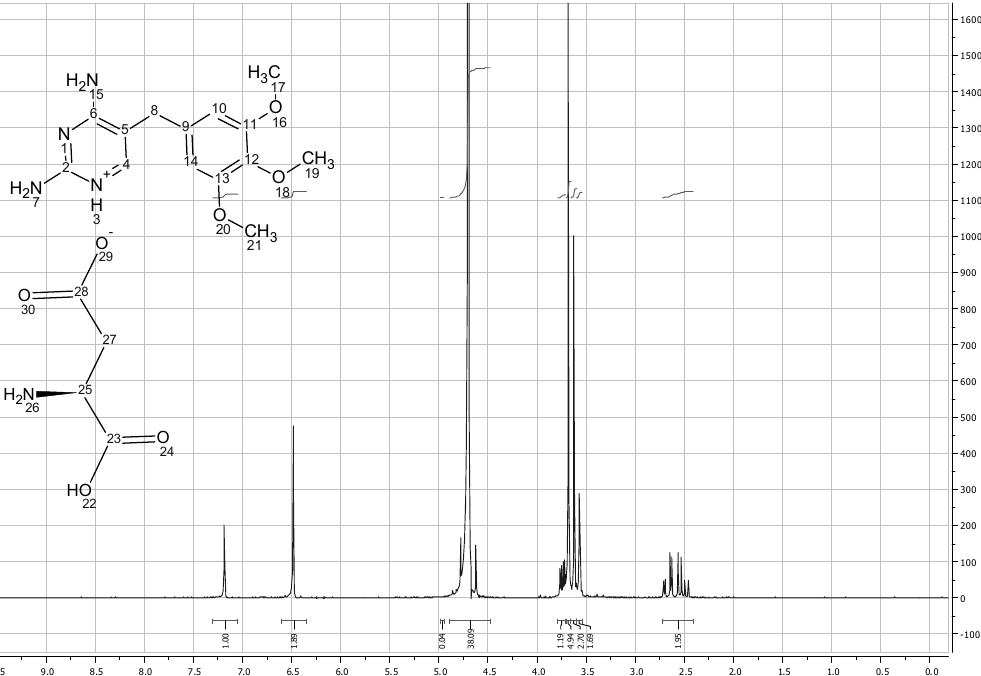
Figure 9. 1 HNMR spectra of trimethoprim L -aspartate solubilized in D